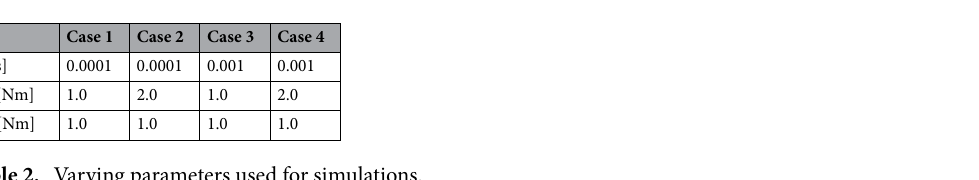
Table 2. Varying parameters used for